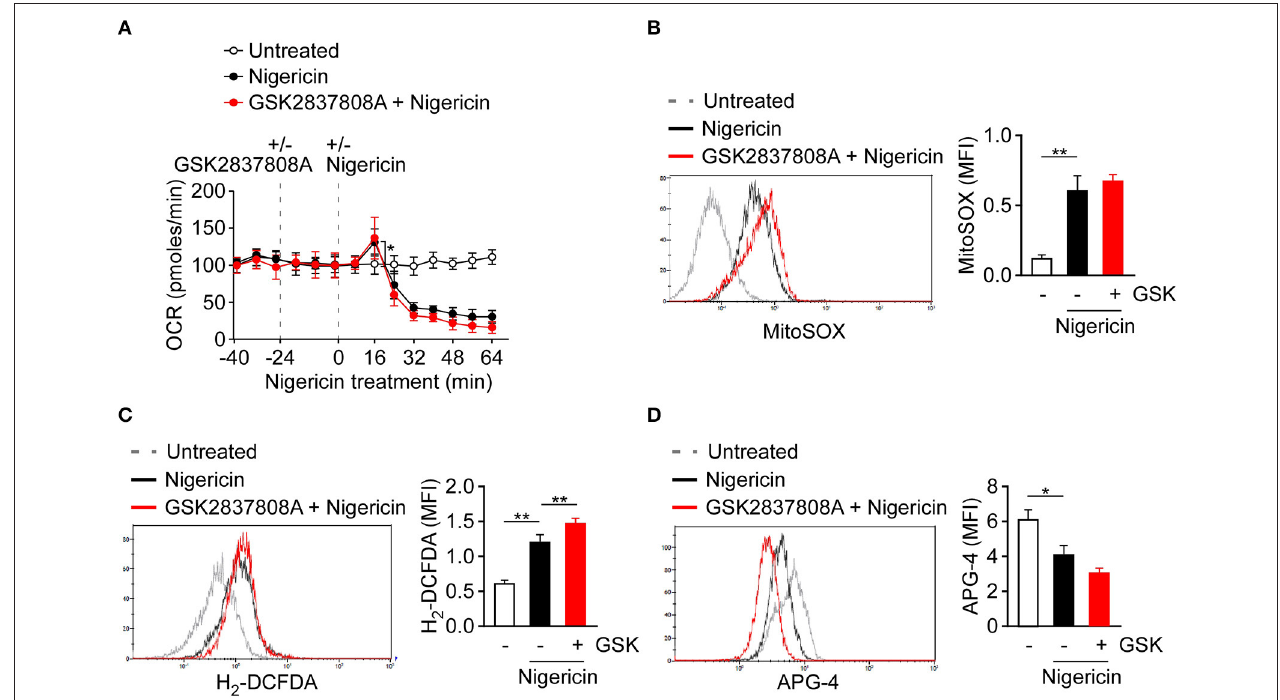
FIGURE 4 | Effect of lactate dehydrogenase inhibition on ROS production and potassium efflux upon NLRP3 inflammasome activation. (A) OCR of THP-1-derived macrophages under sequential treatment with or without GSK2837808A and/or nigericin as indicated by dotted vertical lines. (B, C) Flow cytometry analysis of mitochondrial ROS production (B) and intracellular ROS production (C) in THP-1-derived macrophages pretreated with GSK2837808A for 1h and then stimulated with nigericin for 30min. (D) Flow cytometry analysis of intracellular potassium ion concentration by using APG-4 in THP-1-derived macrophages that had been pretreated with GSK2837808A for 1h, followed by stimulation with nigericin for 30min. * P < 0.05; ** P < 0.01. All results are presented as the mean ± SD of data from three independent experiments ( n = 3 per group), and were analyzed with the ANOVA test followed by post hoc